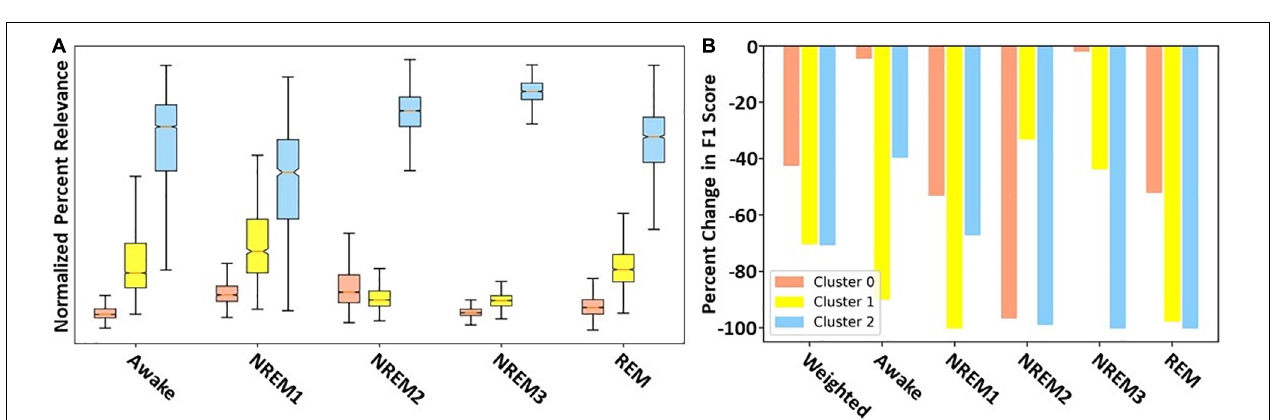
FIGURE 4 | Filter cluster importance with LRP and ablation. Panels (A,B) show the global importance of each cluster of filters using LRP and ablation, respectively. Importantly, red, yellow, and blue values show importance of Clusters 0, 1, and 2,